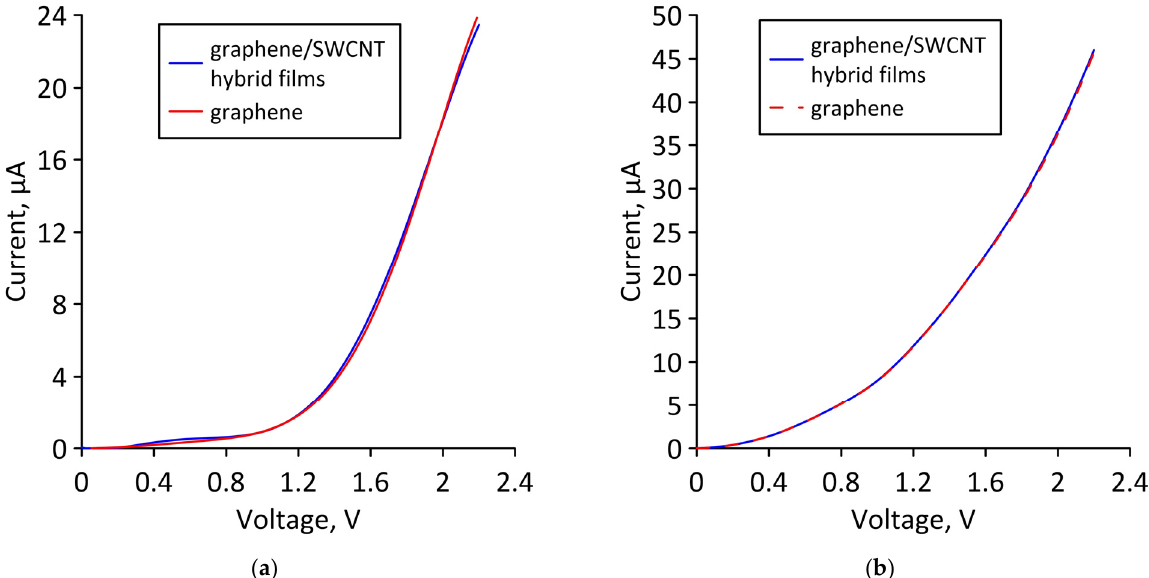
Figure 13. Current-voltage characteristics of bilayer graphene-SW С NT (12,6) hybrid fi lms with is- land topology: ( a ) model V1 at axial compression by 16%; ( b ) model V2 at axial compression by 29%.